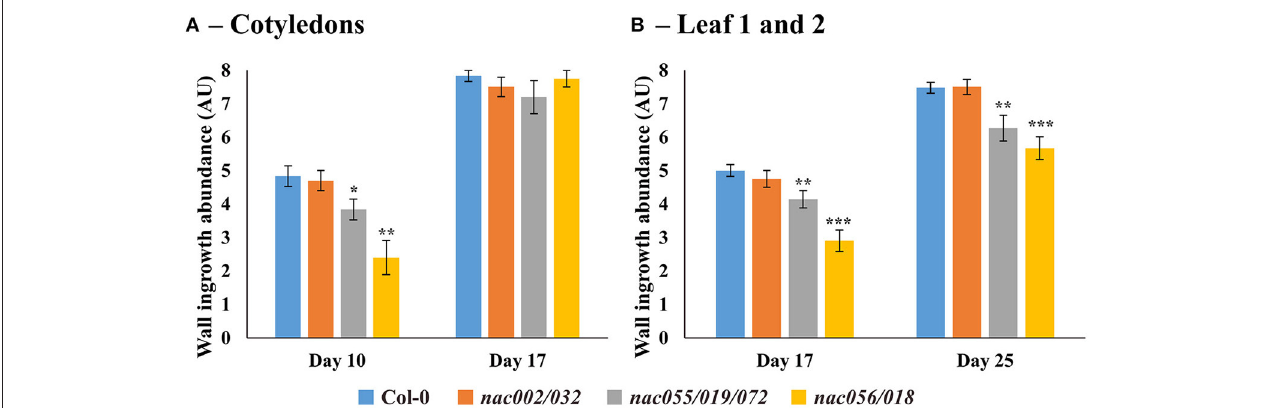
FIGURE 9 | Semi-quantitative analysis of wall ingrowth deposition in Arabidopsis cotyledons and first leaves from Col-0 and nac mutants at selected developmental stages. (A) In cotyledons, by day 10 wall ingrowth deposition in both Col-0 and nac002/032 was indistinguishable, whereas deposition was significantly decreased in both nac055/019/072 ( P < 0.05) and nac056/018 ( P < 0.01). By day 17, however, no difference in wall ingrowth abundance was observed in any nac mutant compared to Col-0. (B) For Leaf 1 and 2 at day 17, wall ingrowth deposition in both Col-0 and nac002/032 was indistinguishable, whereas deposition was significantly decreased in both nac055/019/072 ( P < 0.01) and nac056/018 ( P < 0.001). By day 25, however, again, no differences in wall ingrowth abundance were seen in nac002/032 compared to Col-0, but abundance was significantly reduced in nac055/019/072 ( P < 0.01) and nac056/018 ( P < 0.001) compared to Col-0. Data shows mean ± SE of scores for wall ingrowth deposition in arbitrary units according to the classification scheme of Nguyen et al. (2017). * P < 0.05; ** P < 0.01; *** P < 0.001, student’s t -test comparing wall ingrowth scores in each mutant line compared to Col-0, at each developmental stage; n =